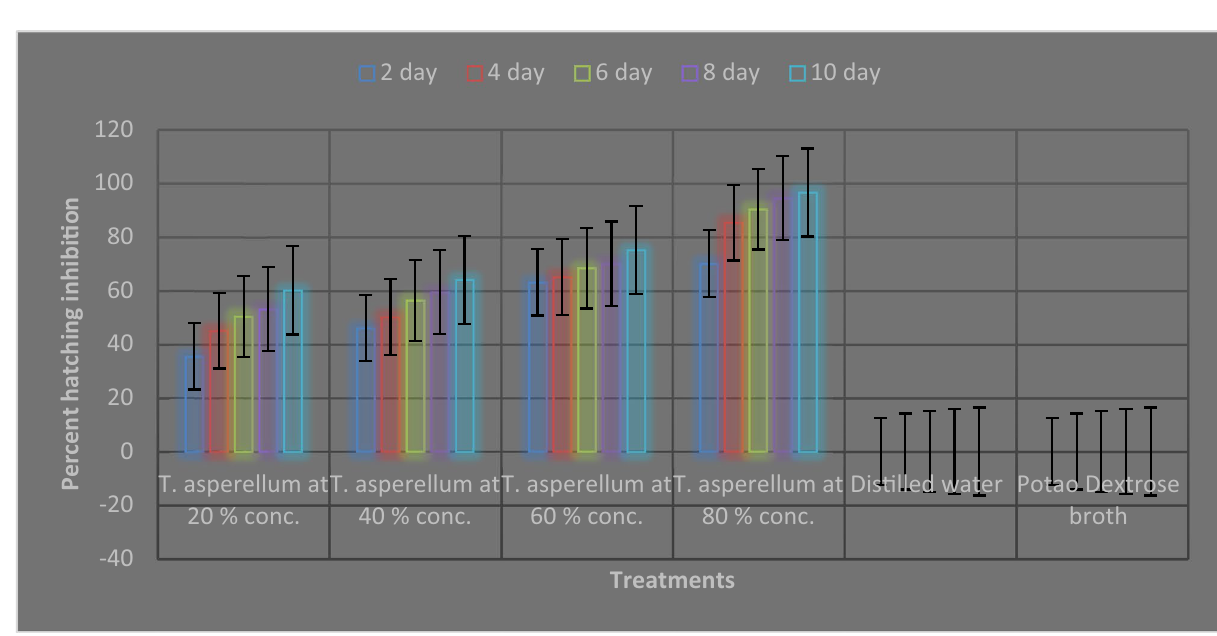
Figure 3. Effect of T. asperellum FbMi6 on egg hatching inhibition of M. incognita under in-vitro